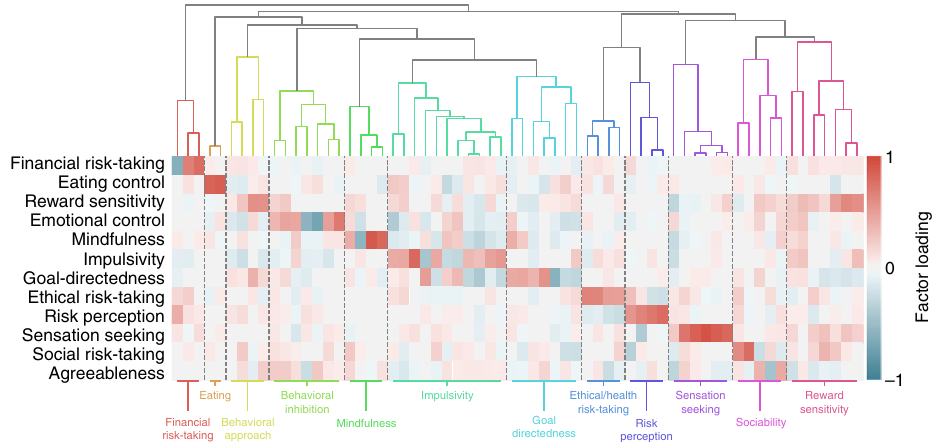
Fig. 3 Survey ontology. 64 survey DVs were projected onto 12 factors discovered using EFA, represented by the heatmap. Rows are factors and columns are separate DVs ordered based on the dendrogram above. The dendrogram was created using hierarchical clustering, and separated into 12 clusters using DynamicTreeCut 34 . Identi fi ed clusters are separately colored, divided by dashed lines in the heatmap, and labeled at the bottom